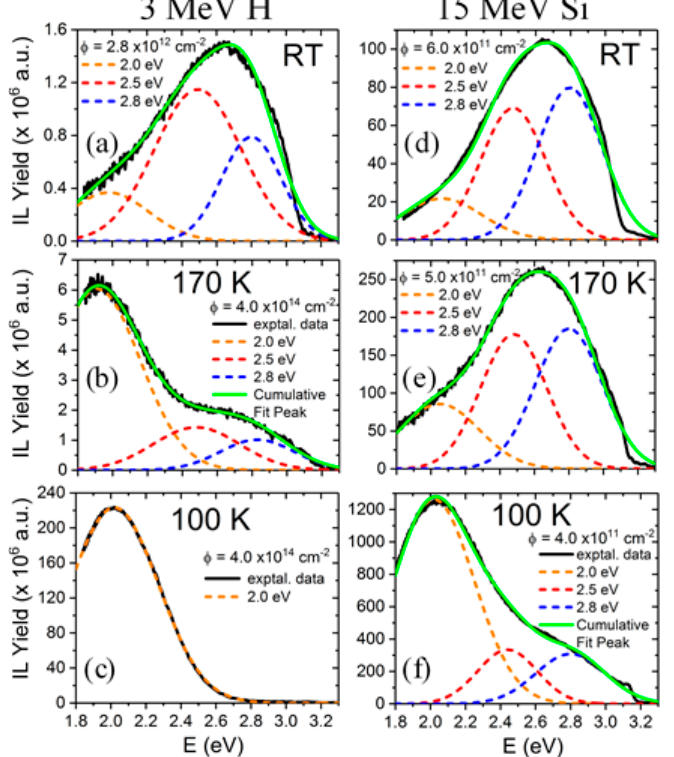
Figure 5. Luminescence emission spectra and Gaussian band components (centered at 2.0, 2.5, and 2.8 eV) of SrTiO 3 obtained under irradiation with several high-energy projectile ions and energies at several temperatures (100 K, 170 K and RT, see labels). Irradiation with 3 MeV H ( a )–( c ) and 15 MeV Si ( d )–( f ) ions have been selected to show the complexity of overlapping emission bands. This figure has been adapted from Crespillo et al. [27].